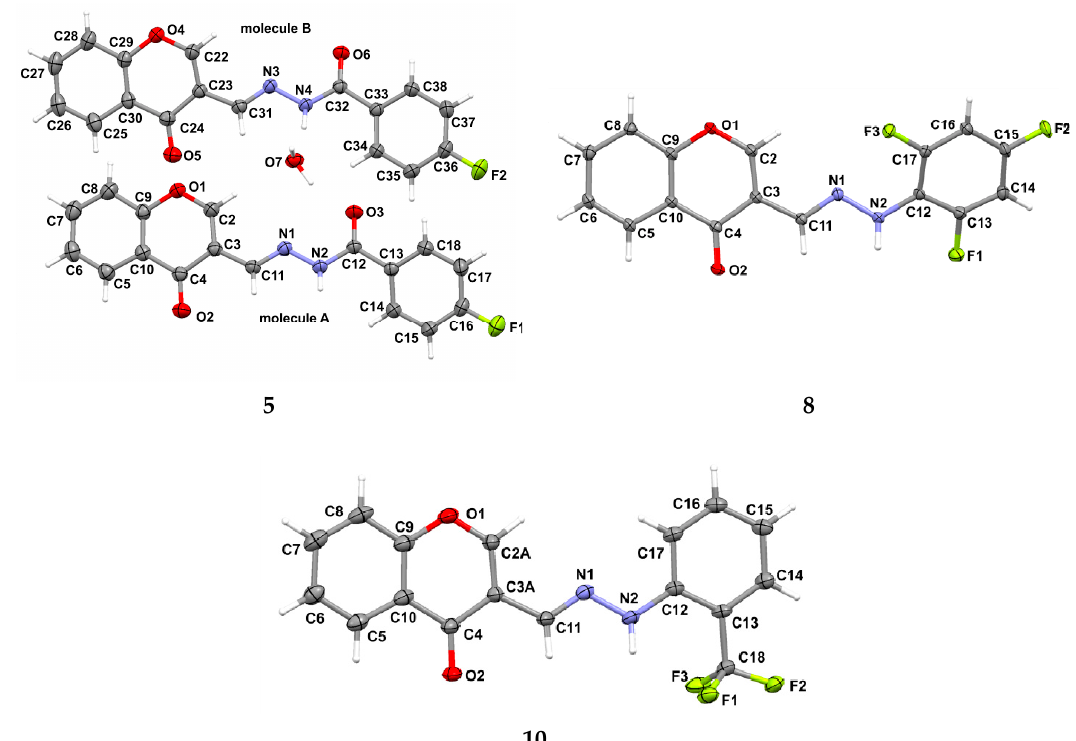
Figure 1. Molecular structures of crystal compounds with anisotropic displacement ellipsoids drawn at the 50% ( 1 , 8 , 10 ) and 30% ( 3 , 5 ) probability level with atomiC-Numbering scheme. Hydrogen atoms are shown as spheres of arbitrary radius. For clarity, only three from six fluorine atoms (F1, F2, F3) with occupancy factor equal to 0.5 are shown for structure 3 . For structure 10 , the carbon atoms with higher site occupancy factors are shown. Table 1. Crystallographic data for 1 , 3 , 5 , 8 and 10